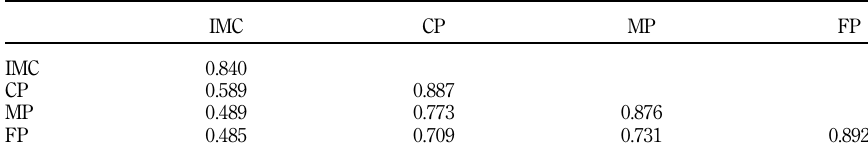
Table 3. Correlation matrix